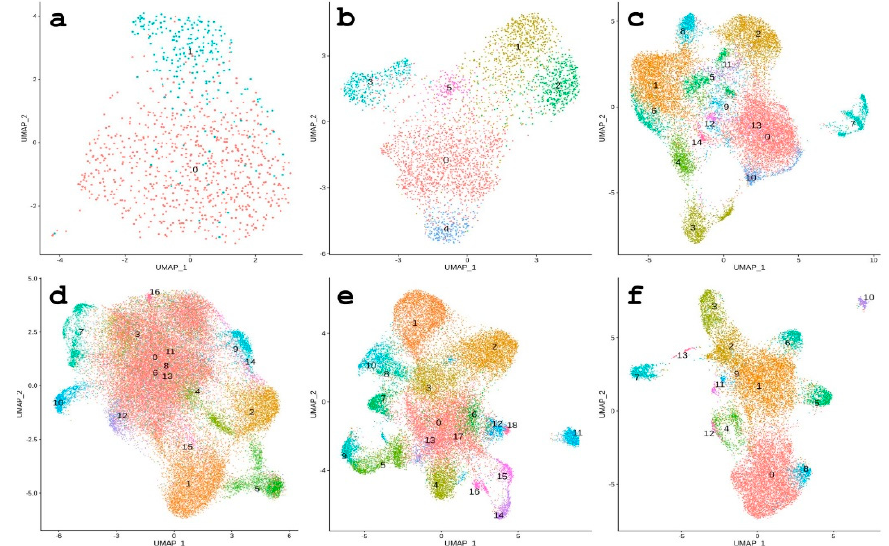
Figure 4. Results of the single-cell RNA-seq analysis. Umap plots of each embryo stage separately. ( a ) 64-cell embryo; ( b ) morula stage; ( c ) hatched blastula; ( d ) mesenchyme blastula; ( e ) early gastrula; ( f ) late gastrula.